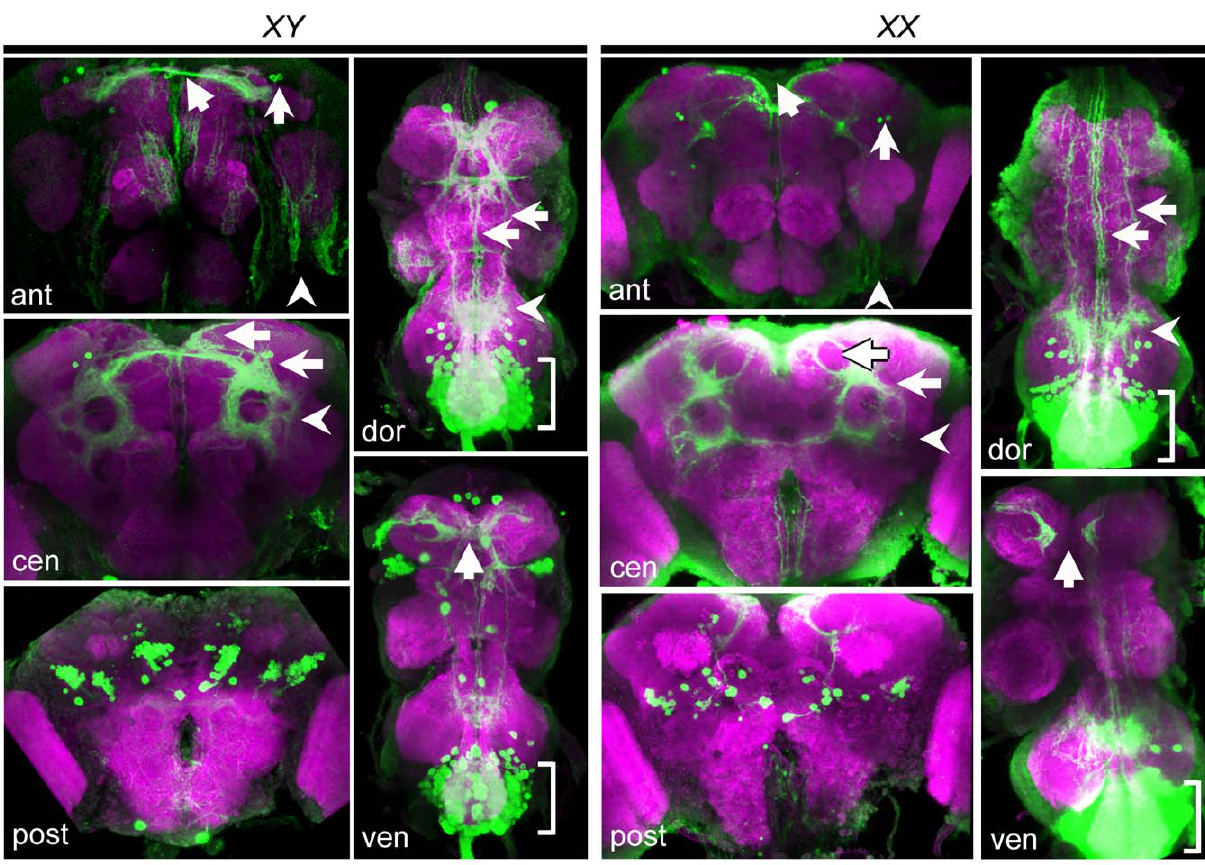
Figure 9. dsx GAL4 is expressed in neurons with sexually dimorphic projections. dsx GAL4 expression in the brains and VNCs of peri-eclosion males ( XY ) and females ( XX ) visualized with UAS-mCD8::GFP membrane-bound GFP reporter (green) and counterstained with DN-Cadherin (magenta). Confocal projections of brain and VNC sections are shown: anterior (ant), central (cen), posterior (post), dorsal (dor), and ventral (ven). For each panel, brains are in the left column and VNCs are in the right column. ( XY ) In the male anterior brain, projections from dsx GAL4 -expressing neurons project through the anterior dorsal commissure (arrow), and there is expression in aDN neurons (barbed arrow) as well as putative glia on the anterior cortex in the anteroventral optic cleft (arrowhead). In the central brain, dsx GAL4 -expressing neurons innervate the dorsofrontal cortex (DFC, arrow), the peripeduncular neuropile (PPN, barbed arrow), and the ventrolateral protocerebrum (VLPR, arrowhead). In the posterior brain, clusters of dsx GAL4 - expressing cells are found, as described in Figure 7. In the ventral VNC, projections of foreleg gustatory neurons are visible crossing the VNC midline (arrow), while in the dorsal VNC, projections are seen in midline and lateral tracts (arrows), and there is an arborization in the dorsal metathoracic neuropile (arrowhead). Extensive expression is also seen in the abdominal ganglion (brackets, dor and ven). ( XX ) In the female brain, the dsx GAL4 expression pattern is similar to that of males but with several differences. In the anterior brain, there are no projections through the anterior dorsal commissure. Putative glia were seen as in males (arrowhead). In the central brain, expression in the DFC (black-outlined arrow), PPN (barbed arrow), and VLPR (arrowhead) is reduced relative to males. In the posterior brain, there is a dramatic reduction in the number of neurons relative to males. In the VNC, there is expression in the abdominal ganglion but not the thoracic cell bodies. The dorsal metathoracic arborization is still visible (arrowhead, ven), as are medial and lateral tracts (arrows, dor). Prothoracic gustatory projections are visible (arrow, ven) but do not cross the midline.